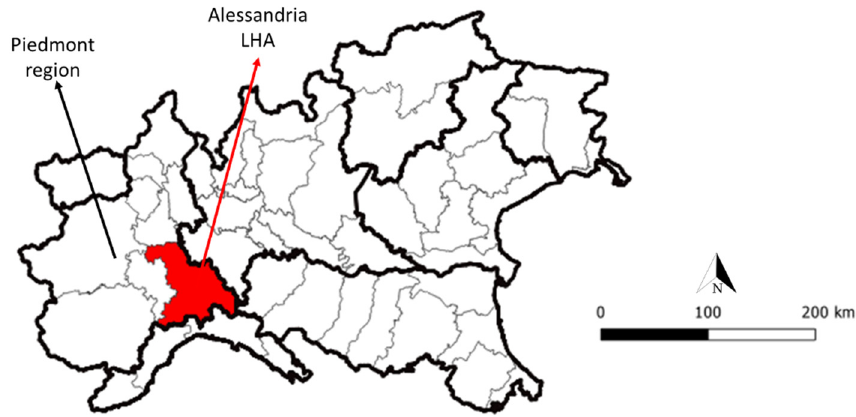
Figure 1. Map of northern Italy reporting the region boundaries with a specific focus on the Alessan- dria LHA (red area).